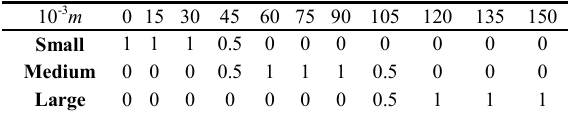
Table 4. Output membership discrete matrix of straight walking.